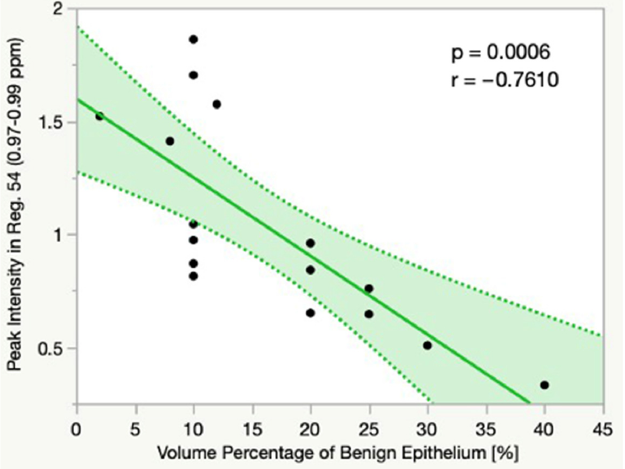
Figure 4. Linear correlation between the Vol.%Epi and the spectral peak intensity in Reg. 54 (0.97–0.99 ppm) in Gr 3. Dotted line = confidence interval. Abbreviations: Vol%Epi = volume percentage of benign epithelium, ppm = parts per million, Reg. = region.